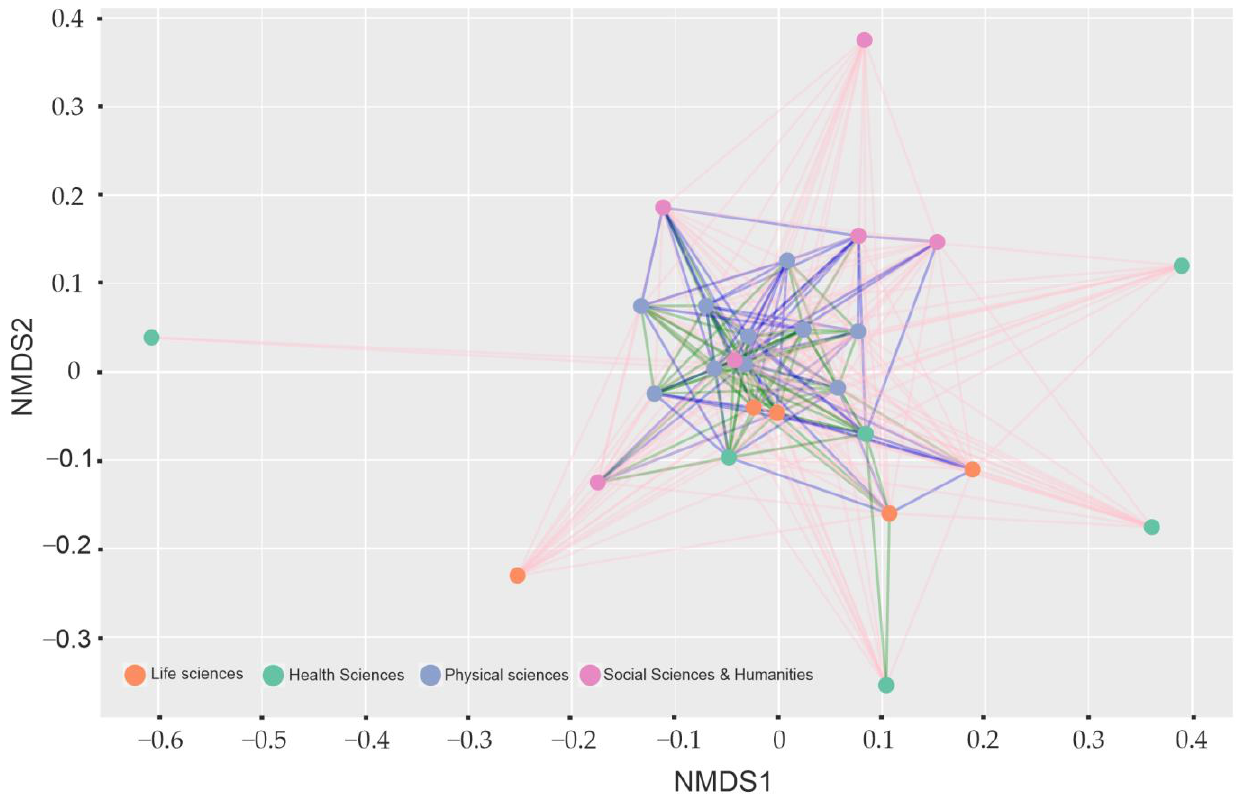
Figure 6. NMDS of the scientific disciplines based on Jaccard dissimilarities. Stress value: 0.137. Point colors denote the affiliation of individual “Subject Areas” to scientific disciplines. Orange: life sciences, pink: social sciences and humanities, blue: physical sciences, green: health sciences. Lines denote the pairwise Jaccard similarity between nodes. Red: below the median of the dataset (0.02967), blue: below the mean (0.06486), green: higher than the mean.